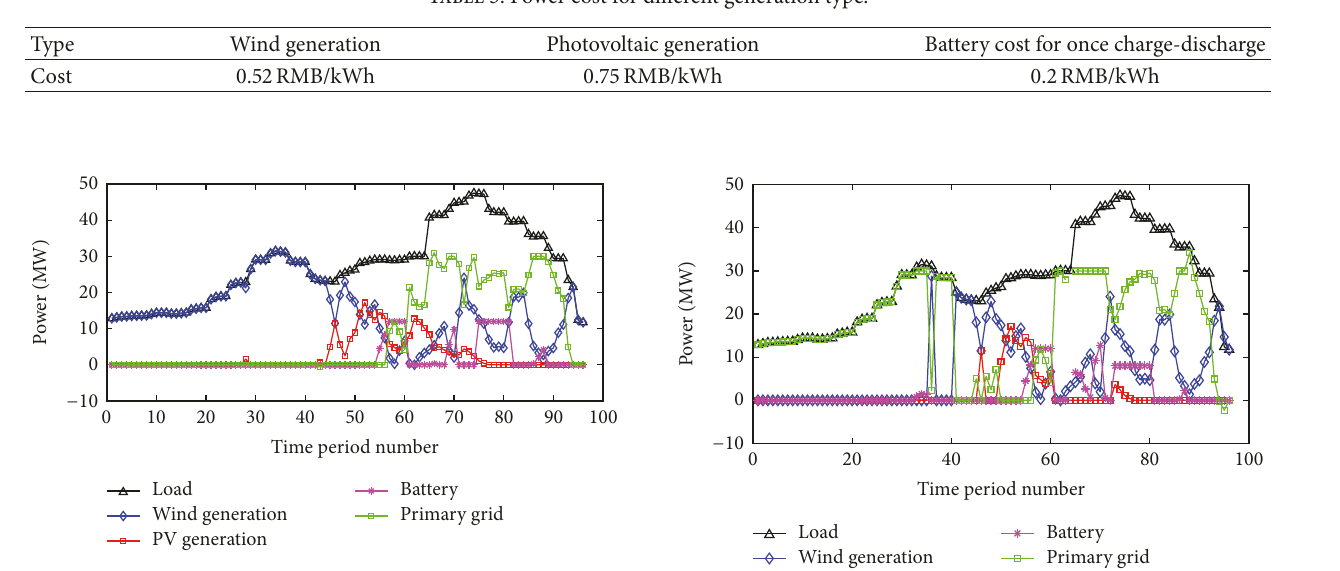
Figure 6: Power dispatching in smog weather condition.